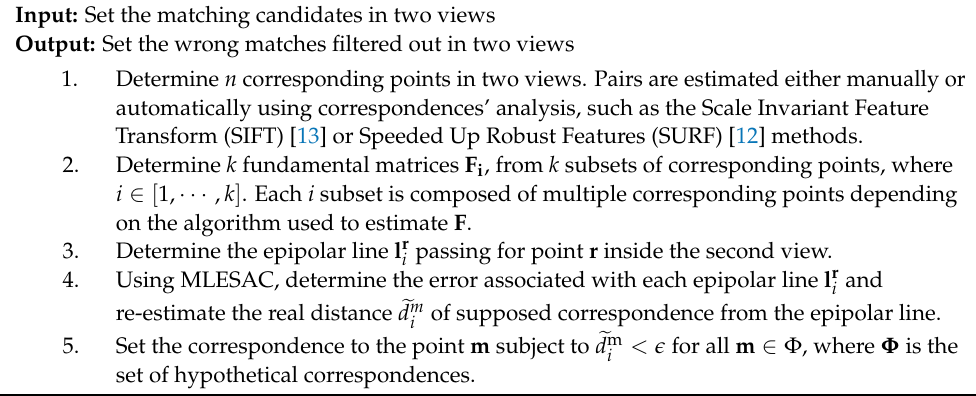
Algorithm 1: Bifocal Geometric Correspondence (BIGC)